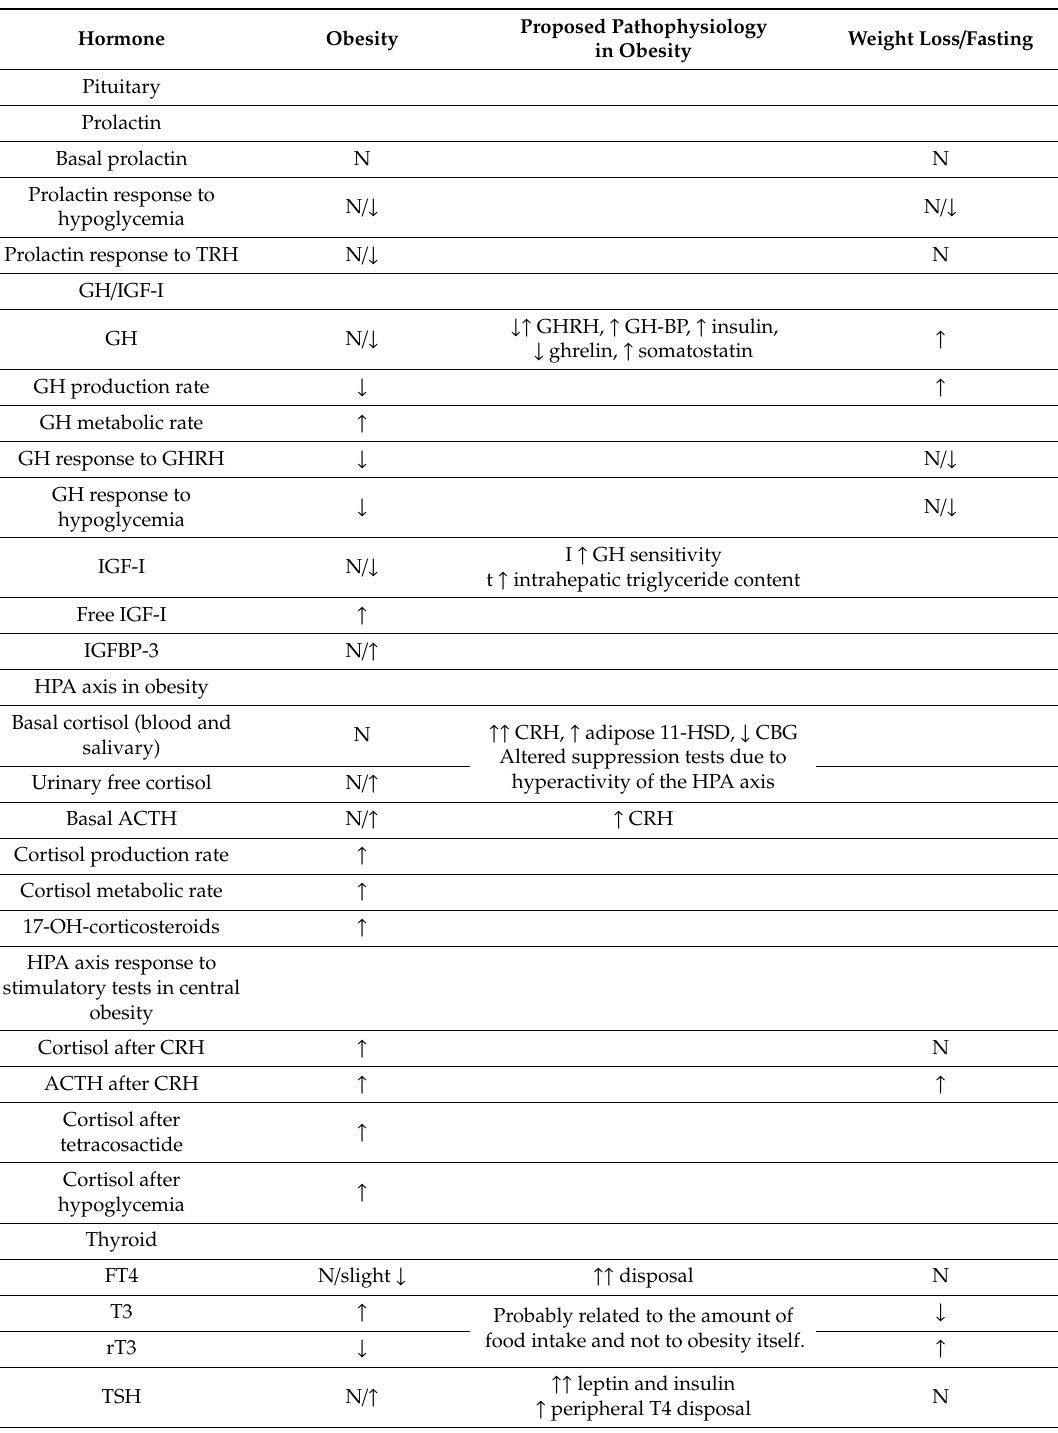
Table 2. Hormonal changes in obesity and after weight loss